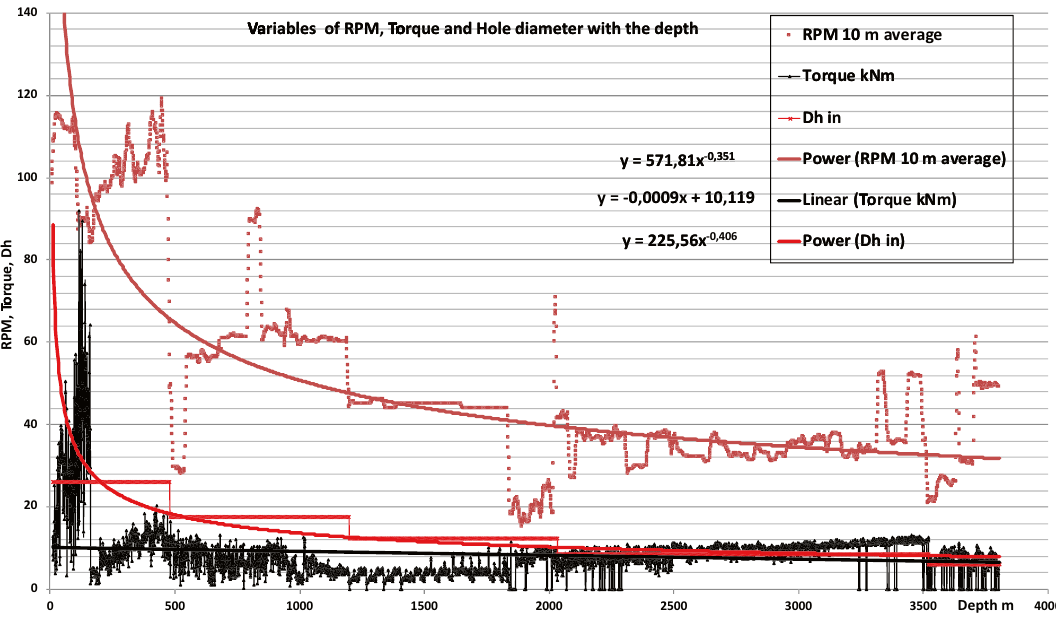
Fig. 7 Relationship between variables RPM, WOB, and bit diameter with